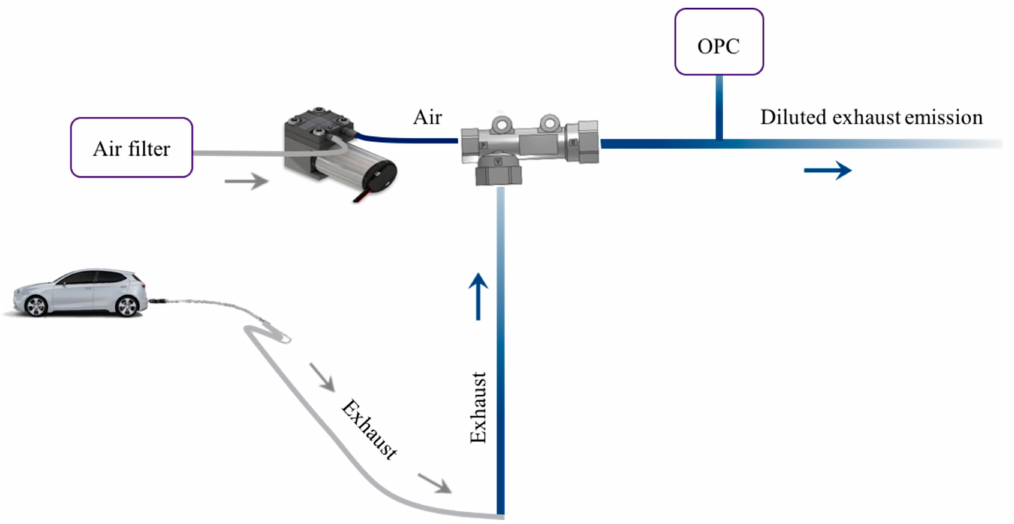
Figure 3. Layout of the system using one ejector for the detection of particulate